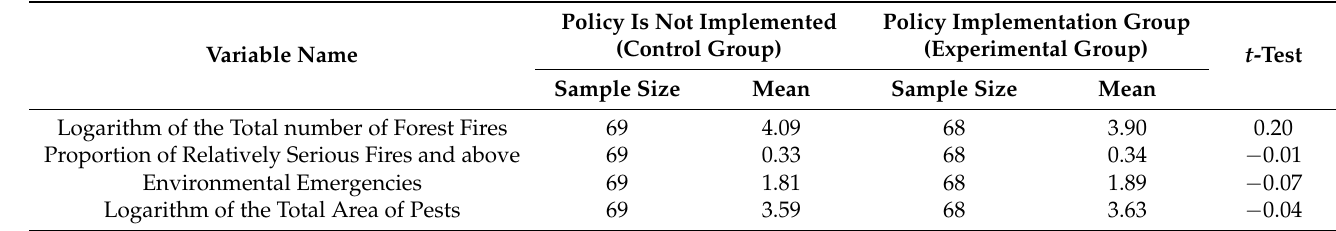
Table 5. Changes in forest disasters between the experimental group and control group before and after policy implementation.